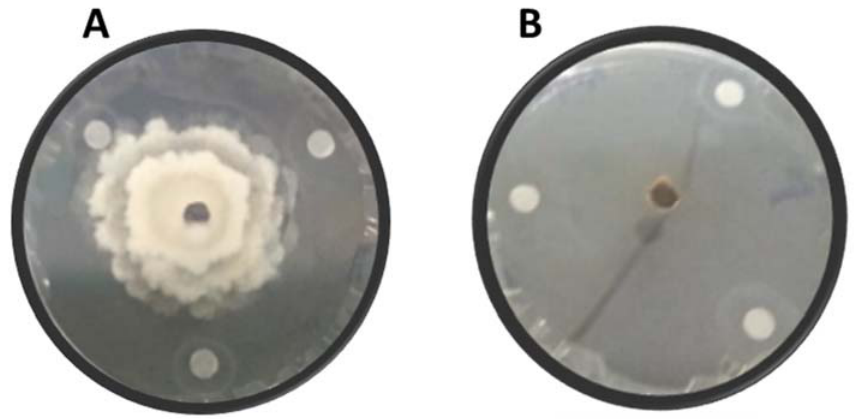
Figure 1. In vitro dual culture of Monilina laxa with essential oil after 7 days of incubation; ( A ) PDA medium inoculated only with M. laxa and ( B ) M. laxa in dual culture with an EO.